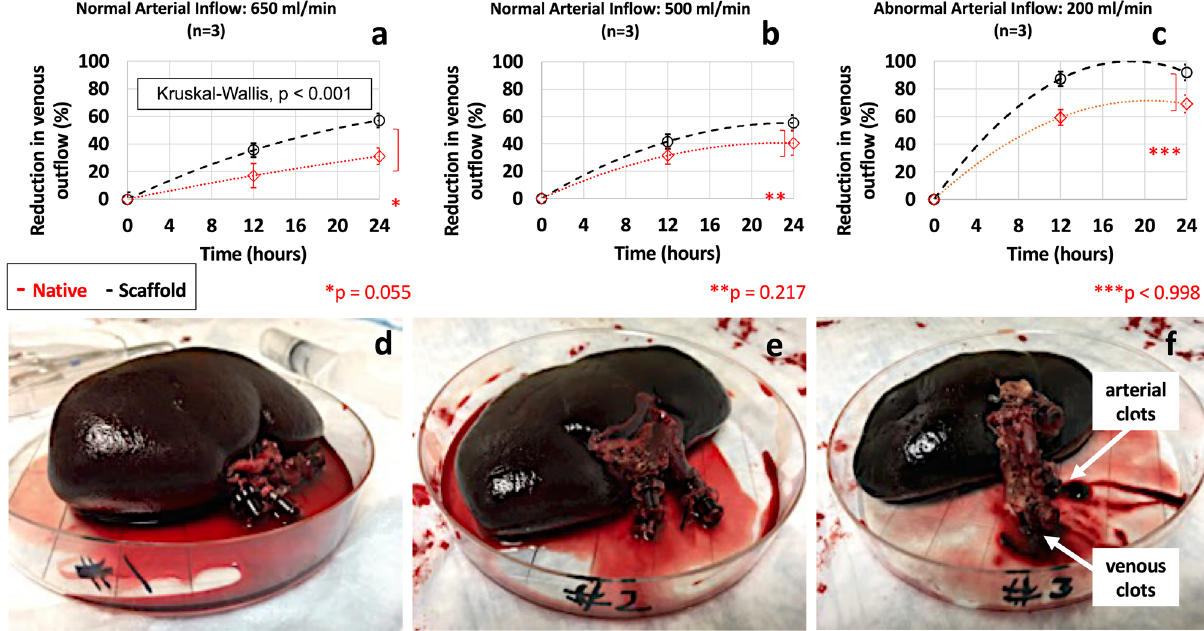
Figure 4. Plots of the time-dependent reductions in venous blood outflow and photographs of kidneys after perfusion. Time-dependent curves display the drops in the venous outflow from decellularized scaffolds subjected to 24 h of blood perfusion at rates of 650 ml/min ( a ), 500 ml/min ( b ), and 200 ml/min ( c ). Data is also presented in images ( a ), ( b ) and ( c ) from control groups of native kidneys perfused with blood for 24 h at 650 ml/min, 500 ml/min and 200 ml/min respectively. Photographs of decellularized scaffolds that were subjected to perfusion at rates of 650 ml/min ( d ), 500 ml/min ( e ), and 200 ml/min ( f ) were taken at the 24-h mark once the perfusion studies were completed. Multiple arterial and venous thrombi were present in scaffolds perfused with blood at a rate of 200 ml/min. The p values presented are based on the Kruskal–Wallis test ( p < 0.001), and pairwise group comparisons are illustrated by means of Dunn’s post-test, which examined the differences between the control group (native kidneys perfused at 650 ml/min) and decellularized scaffolds perfused at 650 ml/min (*), 500 ml/min (**), and 200 ml/min (***) after 24 h of